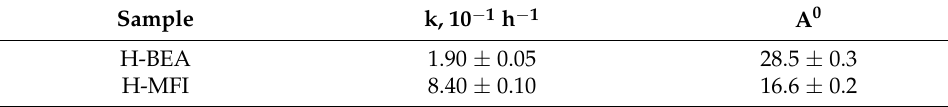
Figure 3. The H-BEA ( a ) and H-MFI ( b ) deactivation curves in A − 1 vs. t R scale. Table 4. Model of H-BEA and H-MFI deactivation at 150 ◦